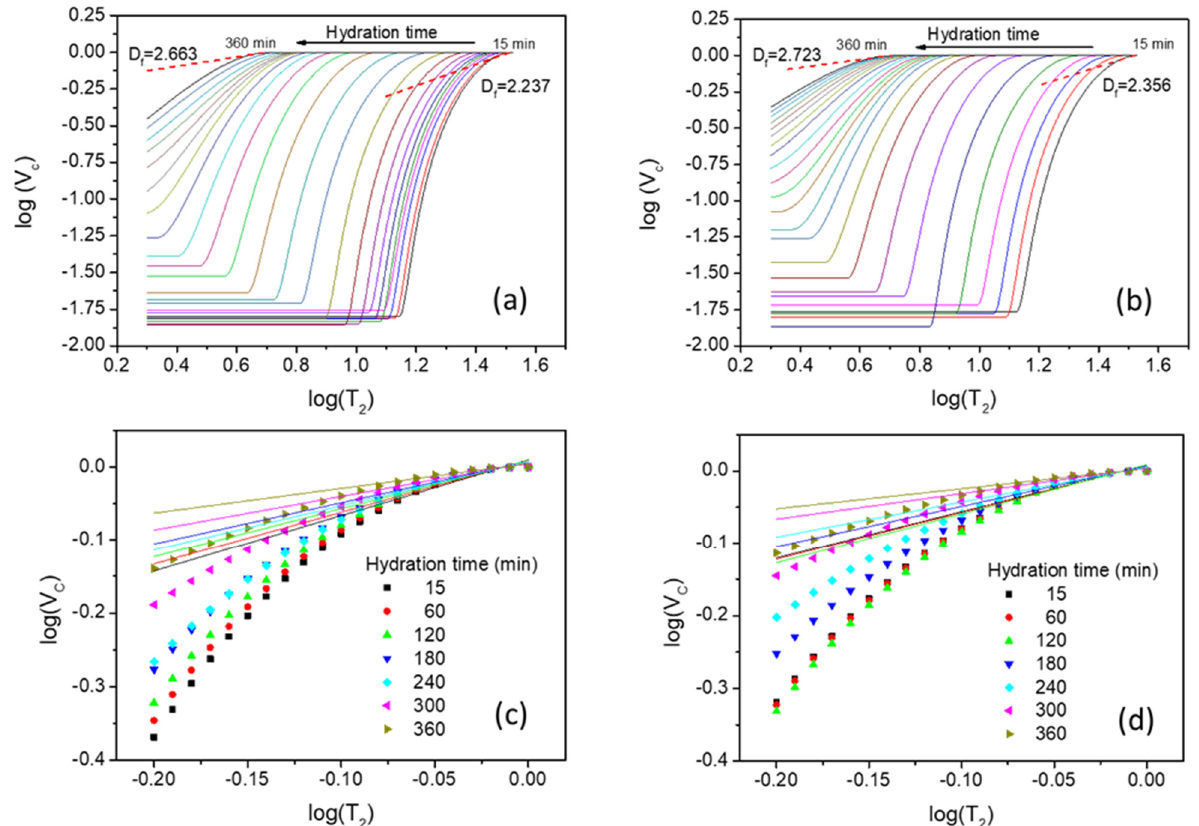
Figure 5. Versus log ( T 2 ) at different hydration times for the capillary water peak in Figure 2 in the case of cement paste sample ( a ) and the cement paste containing the accelerator ( b ). T 2 was considered here in milliseconds. The linear fits with Equation (2) for the two samples were performed after shifting the data on the abscissa axis, for a direct comparison. The same region, between − 0.08 and 0.00 on the abscissa axis, was used for all fits. A continuous change in the slope is observed both for the simple cement paste ( c ) and the sample containing the accelerator ( d ). The coefficients of determination R 2 in all fits were bigger than 0.93, indicating a good linear approximation.